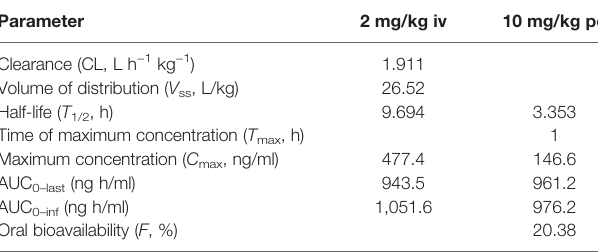
TABLE 1 | Preliminary pharmacokinetic parameters for BH a . Parameter 2 mg/kg